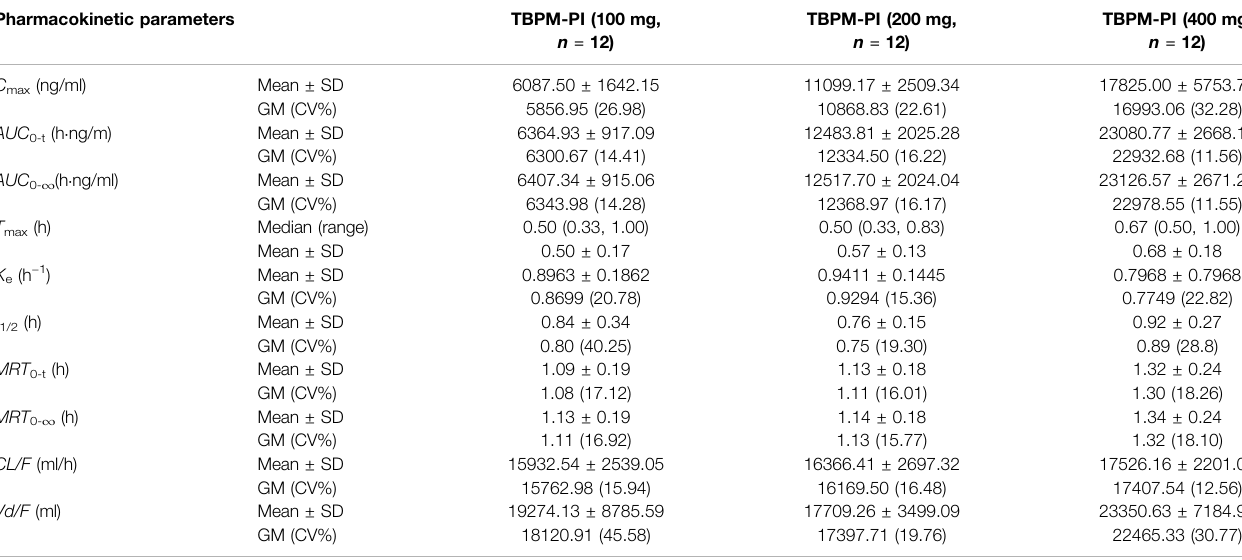
TABLE 2 | Pharmacokinetic parameters of TBPM after oral administration at dosage of 100, 200, and 400 mg. Pharmacokinetic